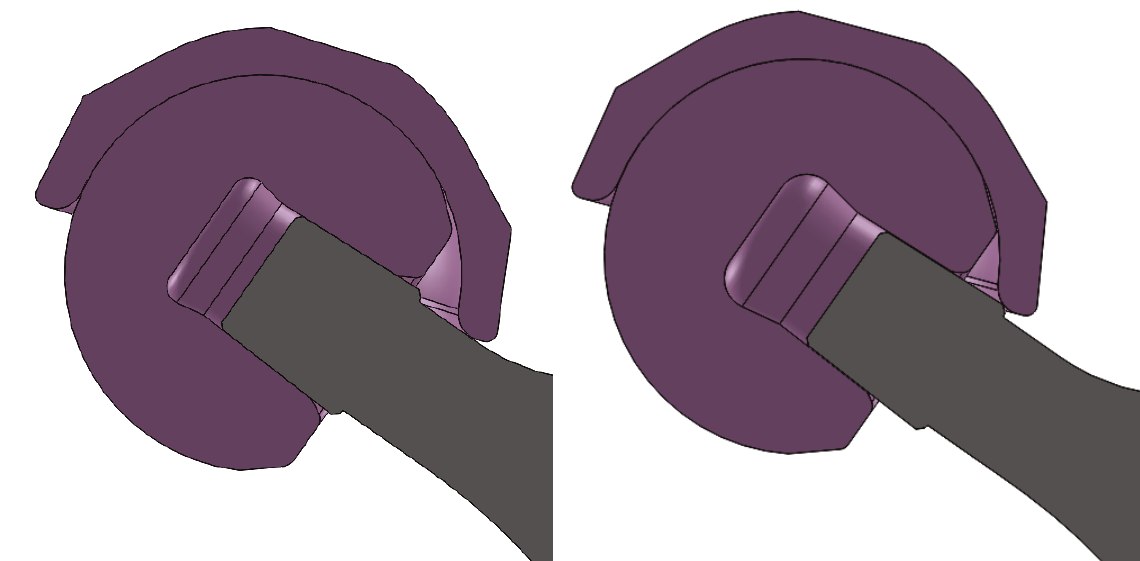
Figure 8: (Left) Liner impinges at stem neck with a +4mm offset head. (Right) Liner impinges at stem trunnion with a +8mm offset